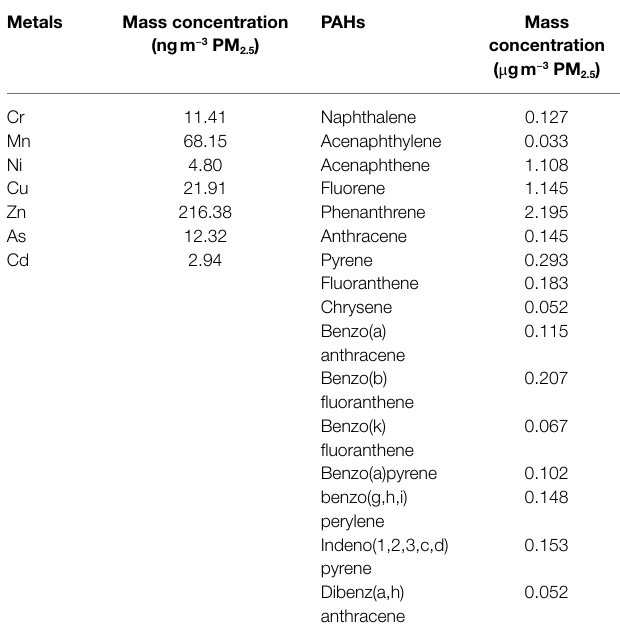
TABLE 1 | Average mass concentration of metals and polycyclic aromatic hydrocarbons (PAHs) in PM 2.5 . Metals Mass concentration (ng m − 3 PM 2.5